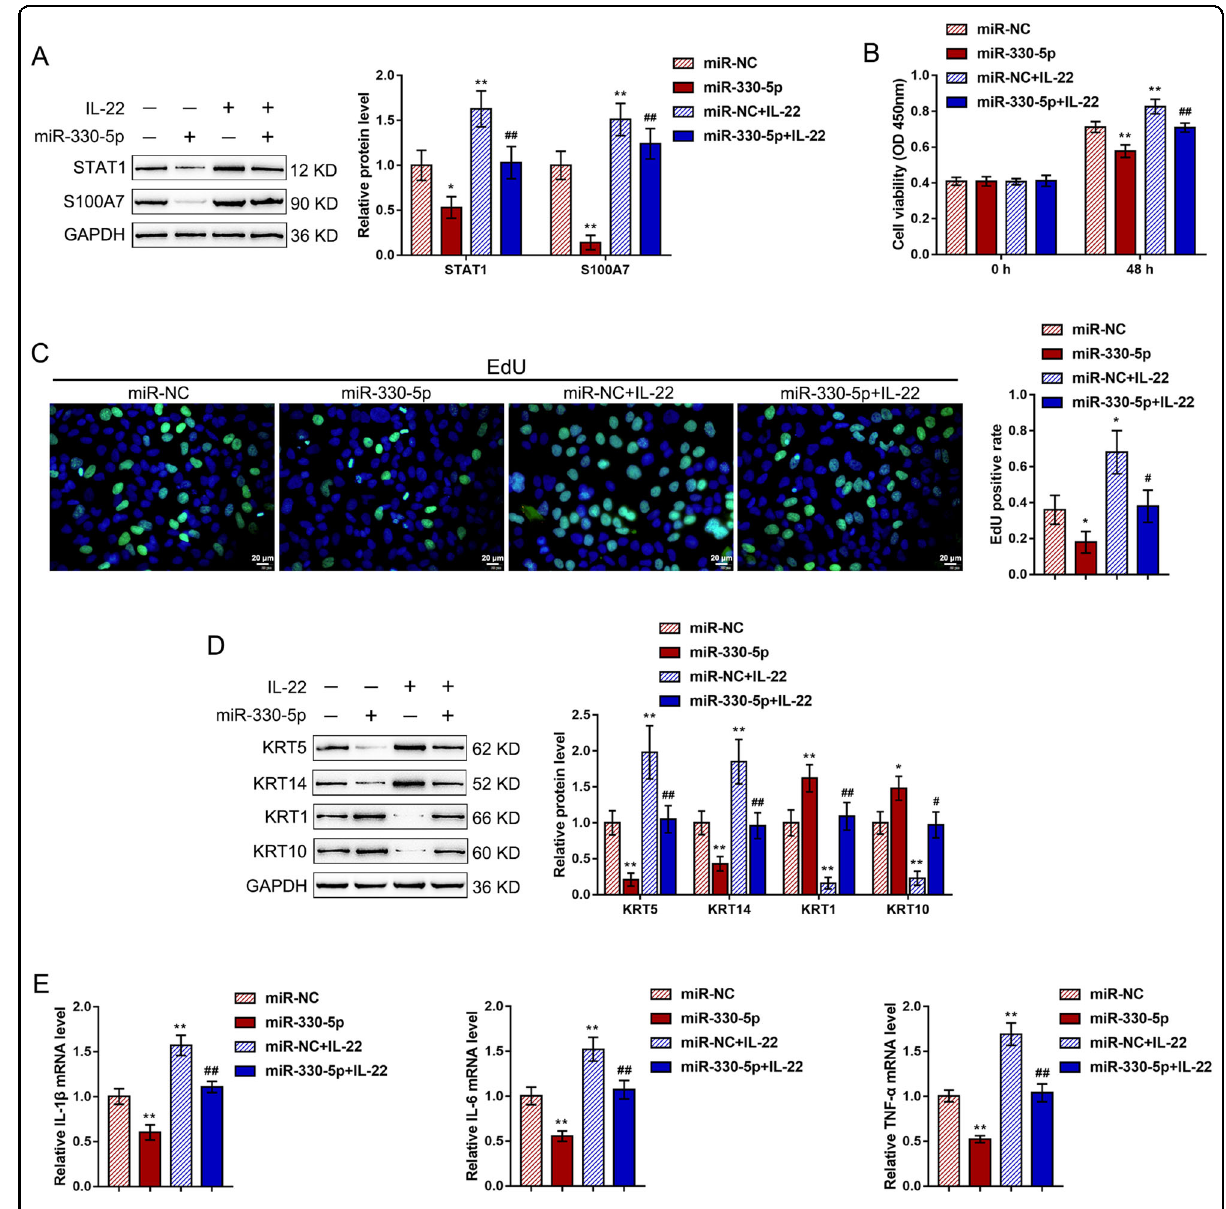
Fig. 5 Effects of miR-330 on STAT1 and S100A7 and IL-22-induced HaCaT cells. HaCaT cells were transfected with miR-330-5p in the presence or absence or IL-22 and examined for ( A ) the protein levels of STAT1 and S100A7 by immunoblotting; B the cell viability by MTT assays; C DNA synthesis by EdU assays; D the protein levels of KRT5/14/1/10 by immunoblotting; E and the mRNA expression levels of IL-1 β , IL-6, and TNF- α by real- time PCR. * P < 0.05, ** P < 0.01, compared to the control group; # P < 0.05, ## P < 0.01, compared to the miR-NC + IL-22